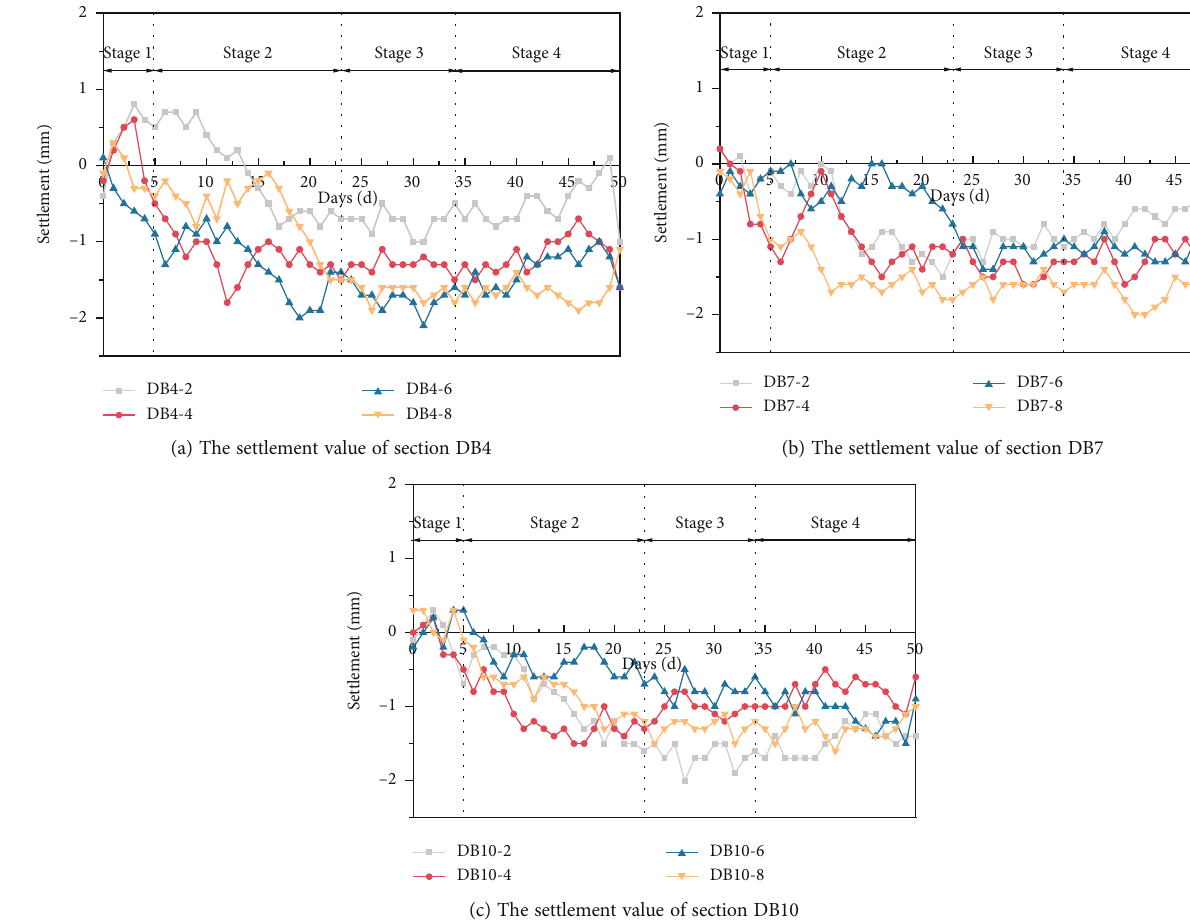
Figure 14: Longitudinal surface subsidence of di ff erent monitoring